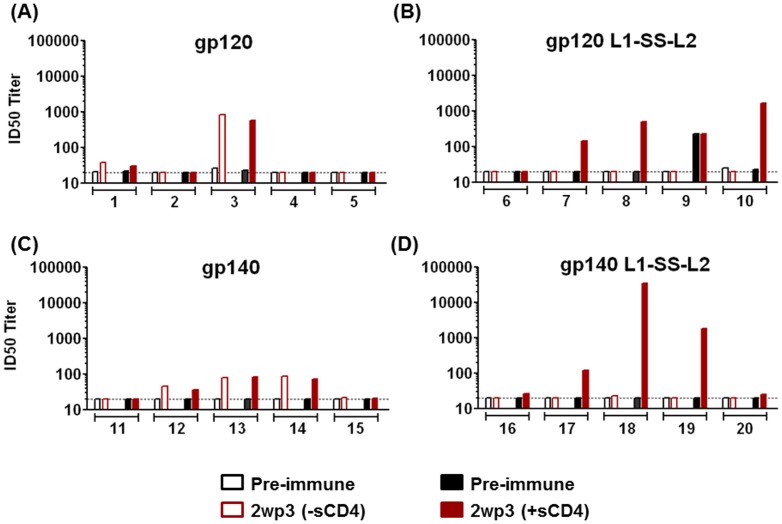
Neutralization of HIV-2 in the presence and absence of sCD4.Individual rabbit sera were tested for neutralizing activity against HIV-2 (7312A/V434M) in the absence (open bars) or presence (filled bars) of sCD4. The 50% neutralizing titers are shown for the pre-immune (black) and 2wp3 (red) serum samples. The antigens used for immunization are indicated above each graph (A – gp120, B – gp120 L1-SS-L2, C – gp140, D- gp140 L1-SS-L2); the numbers on the x-axis indicate the rabbit numbers. The dotted lines indicate the lowest dilution tested, 1∶20, that serves as the background.